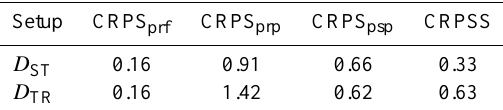
Table 4. CRPS and CRPSS values for D ST and D TR . The CRPSS value for D TR shows a much larger improvement in predictive ca- pabilities for this model setup compared to D ST